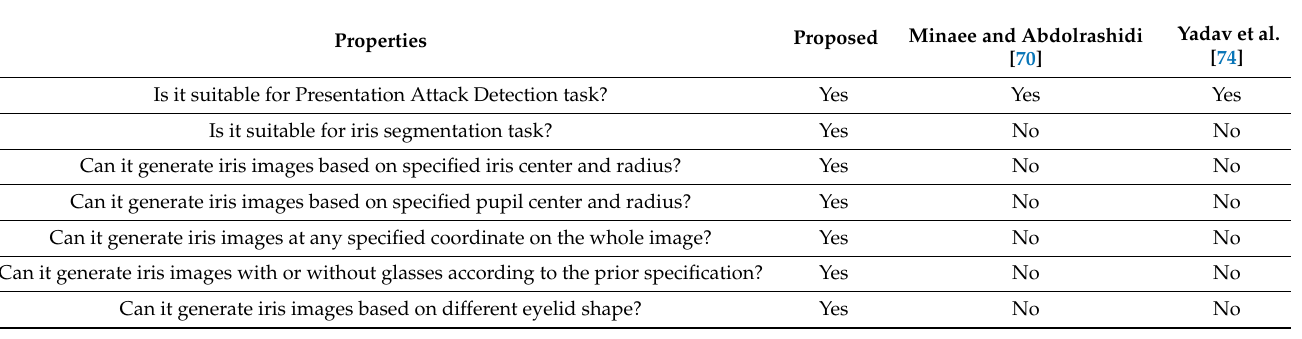
Table 5. The strength and weakness of the proposed method compared to the prior work on down- stream tasks.